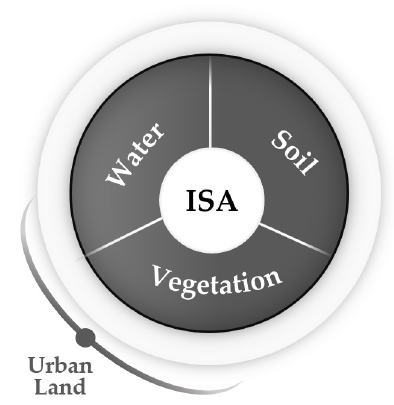
Figure 2. The diagram of the proposed indirect impervious surface area (ISA) extraction conceptual model. To extract the center white area (ISA) indirectly is to detect and mask the surrounding dark area (background land cover, including vegetation, soil, and water) in the total urban land area.